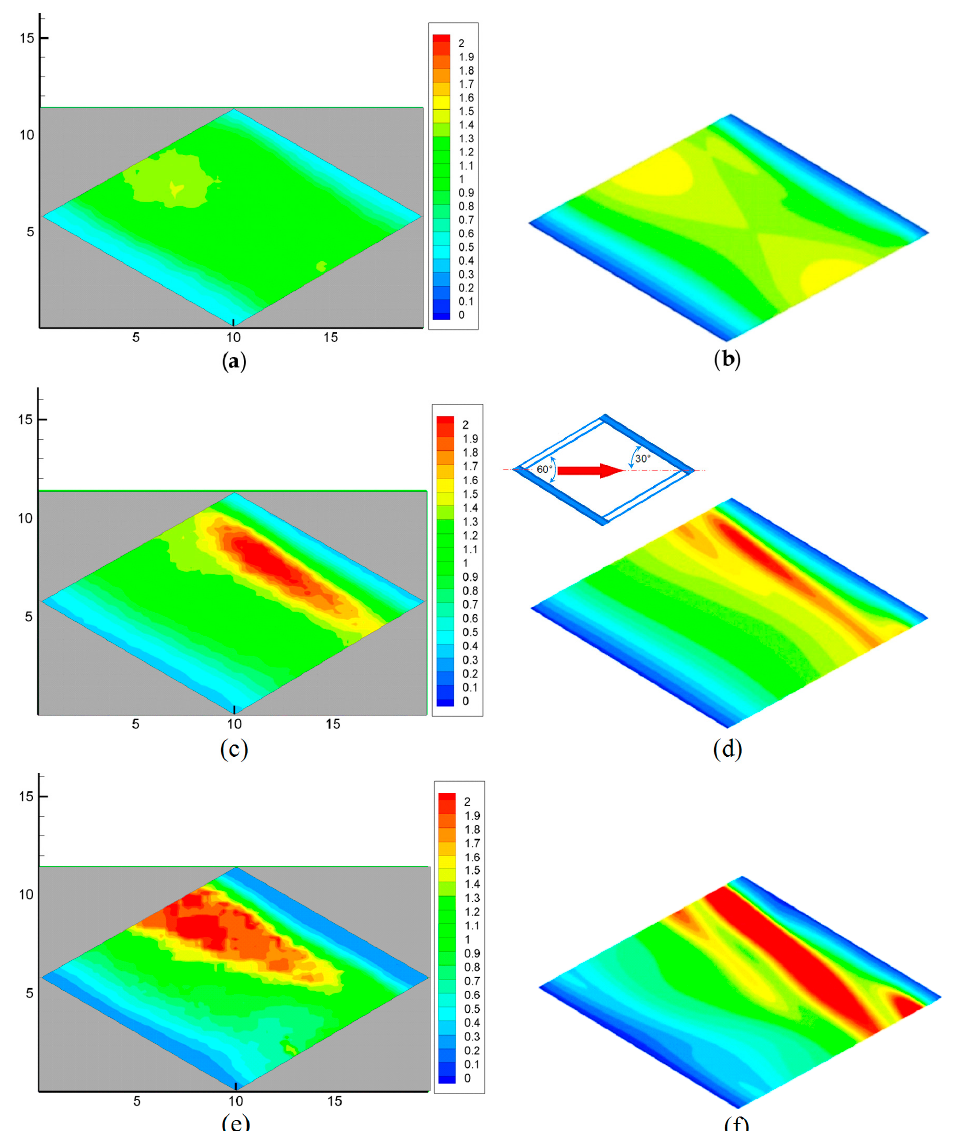
Figure 6. Configuration 1: distributions of the normalized heat transfer coefficient for increasing flow rates. ( a , b ) Q = 1 L / min. Re ≈ 205; ( c , d ) Q = 2 L / min. Re ≈ 410; ( e , f ) Q = 4 L / min. Re ≈ 820. Left column ( a , c , e ) experimental results; right column ( b , d , f ) computational fluid dynamics (CFD) predictions. Coordinates are in mm.